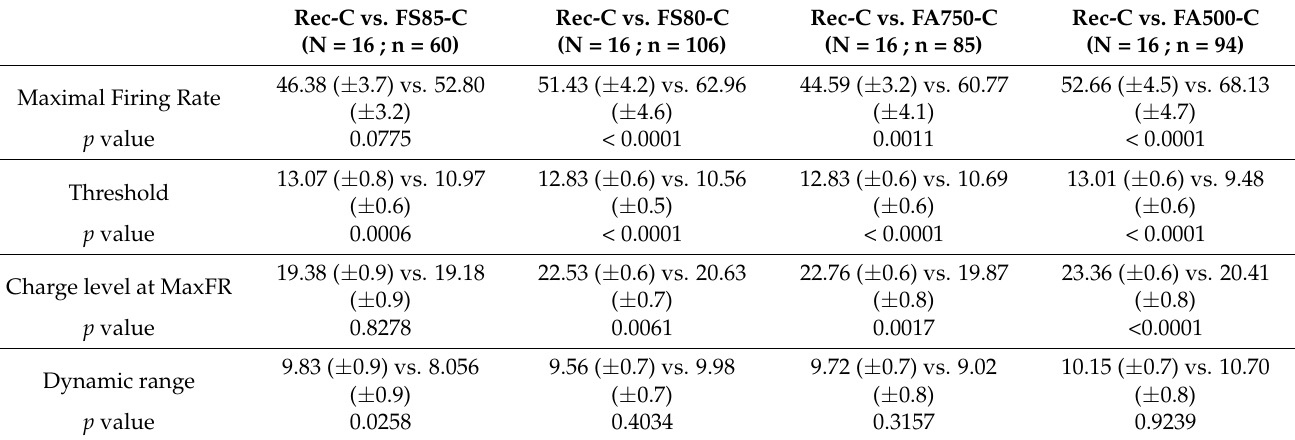
Table 1. Mean ± sem of the parameters extracted from the responses of ACx neurons with cathodic- first pulses. For each comparison, N refers to the number of animals and n refers to the number of recordings providing significant responses to both pulse shapes.